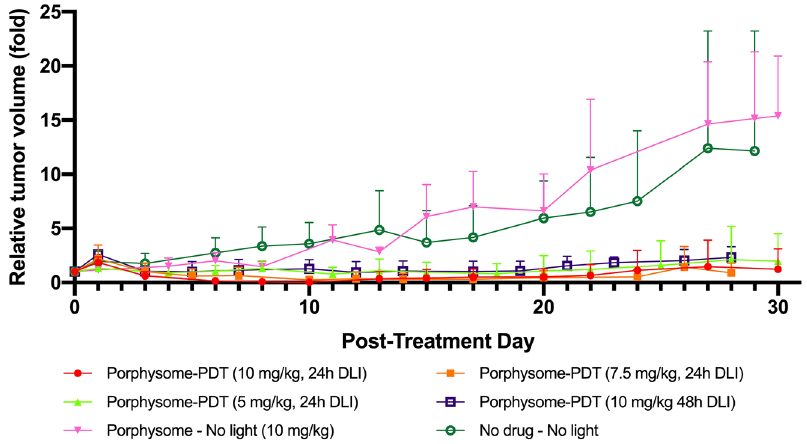
Figure 2: Relative tumor volume across the treatment and control groups in the 30 d post-PDT follow-up period. ( n = 5 for all groups; except n = 6 for the PS 10 mg/kg, 24hDLIgroup).Mean ± 1S.D.withhalfbars shown for